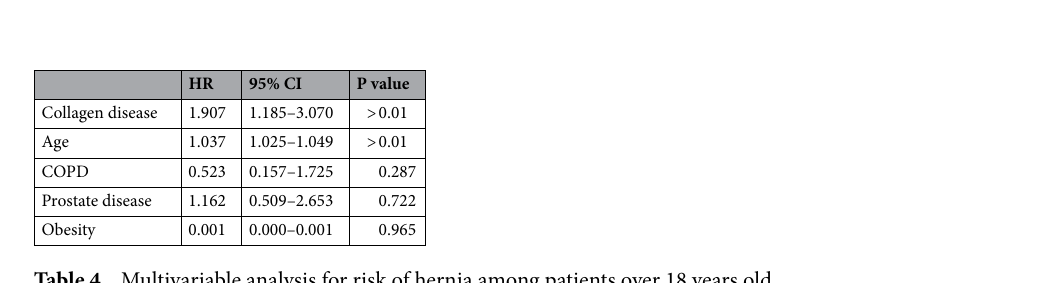
Table 3. The incidence of developing unilateral, bilateral and all hernia between collagen group and control groups.